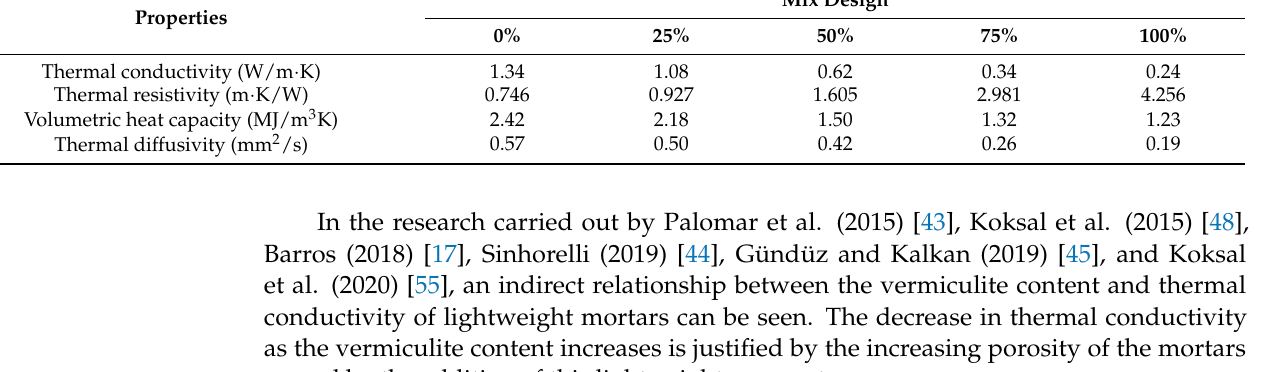
Figure 13. Correlation between thermal conductivity and porosity from the study by Palomar et al. (2015) [44]. Figure 14. Correlation of vermiculite content, thermal conductivity, and porosity results from the study by Koksal et al. (2015) [48].